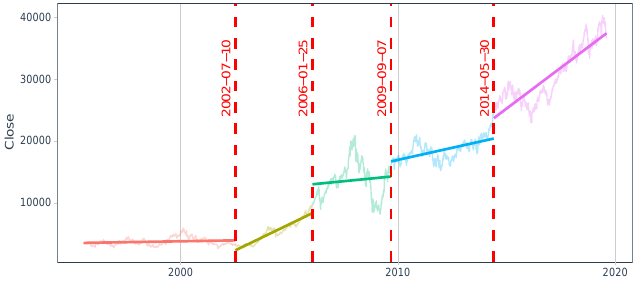
Figure 3. Visualization of segment-wise structural